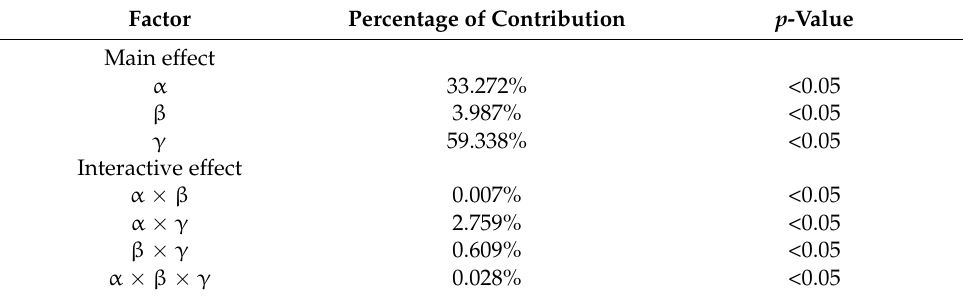
Figure 7. Main effects of multiple parameters on the system’s benefits. Table 6. Contributions of the individual and interactive factors.